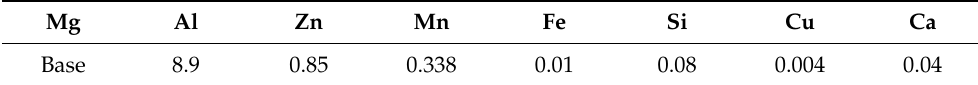
Table 1. Chemical composition of the AZ91 alloy in wt.%. Mg